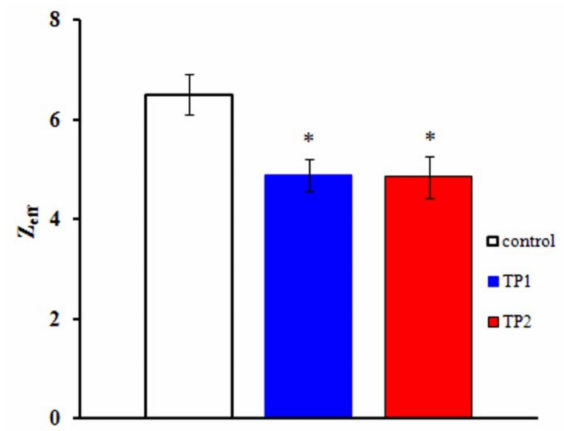
Figure 3. TP1 and TP2 decrease the effective charge of the Na V 1.8 channel activation gating device. The Z eff values of the Na V 1.8 channel activation gating device after application of TP1 and TP2: control, Z eff = 6.5 ± 0.4 ( n = 23); effective charge after application of TP1, Z eff = 4.9 ± 0.3 ( n = 22); effective charge after application of TP2, Z eff = 4.8 ± 0.4 ( n = 19). Statistically significant differences between the control and experimental values are designated with asterisks ( p < 0.05).